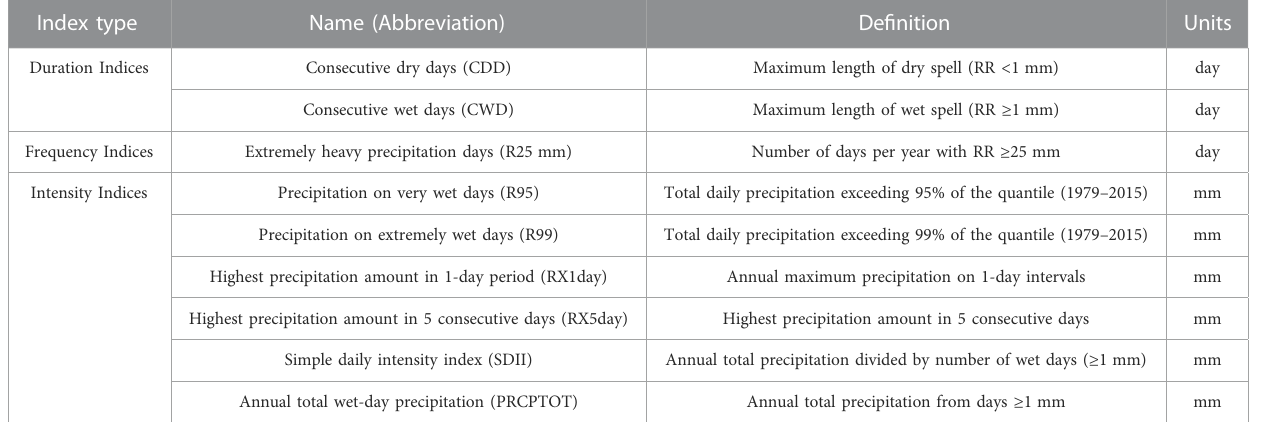
TABLE 1 De fi nition of the precipitation indices used in this